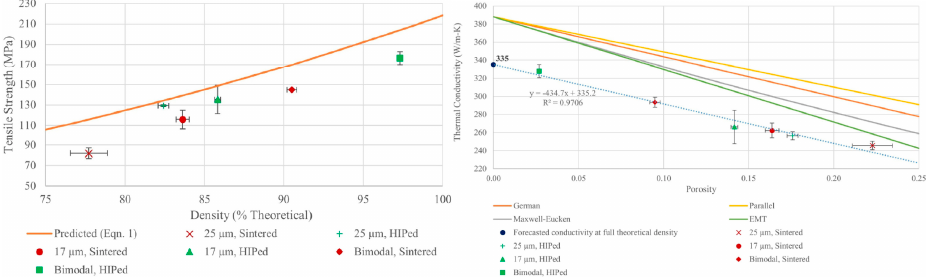
Figure 18. Performance comparison of different parts. Adapted from [48] Elsevier, 2019.